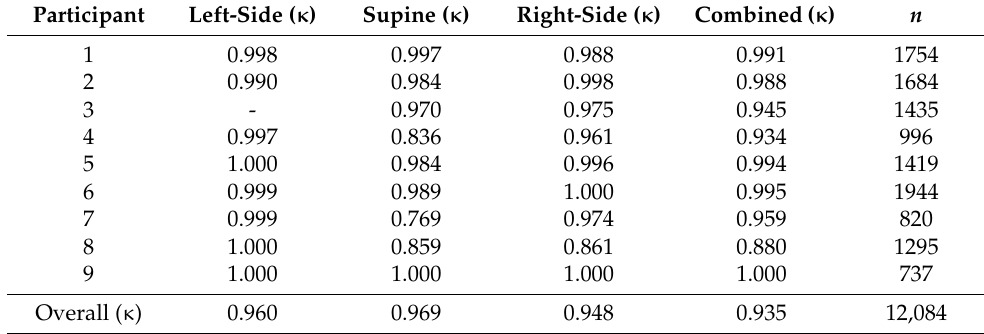
Figure 7. Sample time ‐ lapse images of Participant 1. Table 7. Results of the inter-rater reliability analysis using Fleiss’s kappa ( κ ).